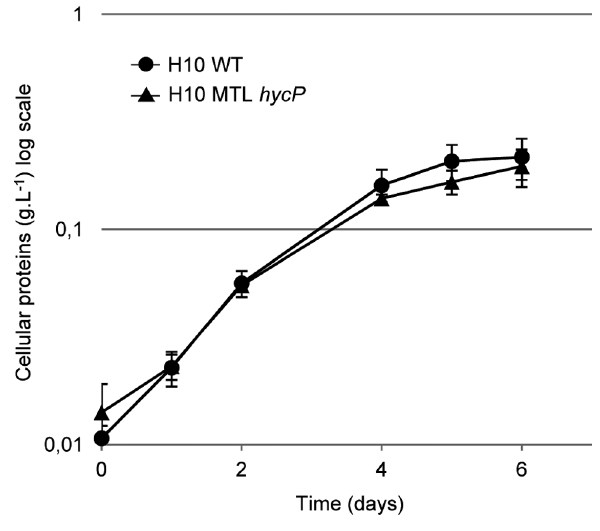
Figure 6. Growth of Clostridium cellulolyticum wild-type and MTL hycP strains on cellulose. Both strains were grown on rich medium containing 5 g.L 2 1 Sigmacell. Growth was monitored by measuring total protein content. Experiment was performed in duplicates. Growth performed in other condition as minimal medium containing Sigmacell or Avicel did not show any differences between both strains.